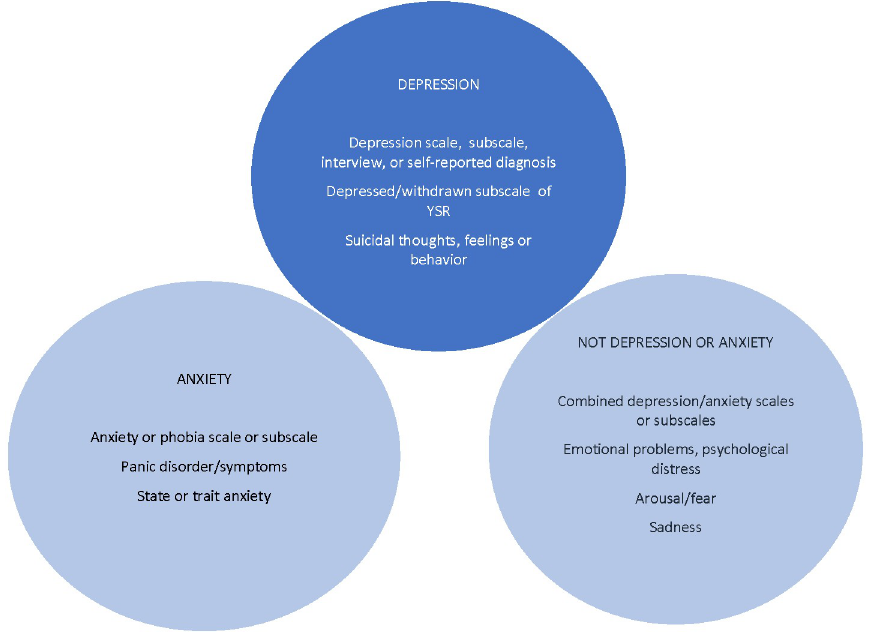
Fig 2. Domains used to define depression and anxiety as constructs for analysis. YSR = Youth Self Report scale.